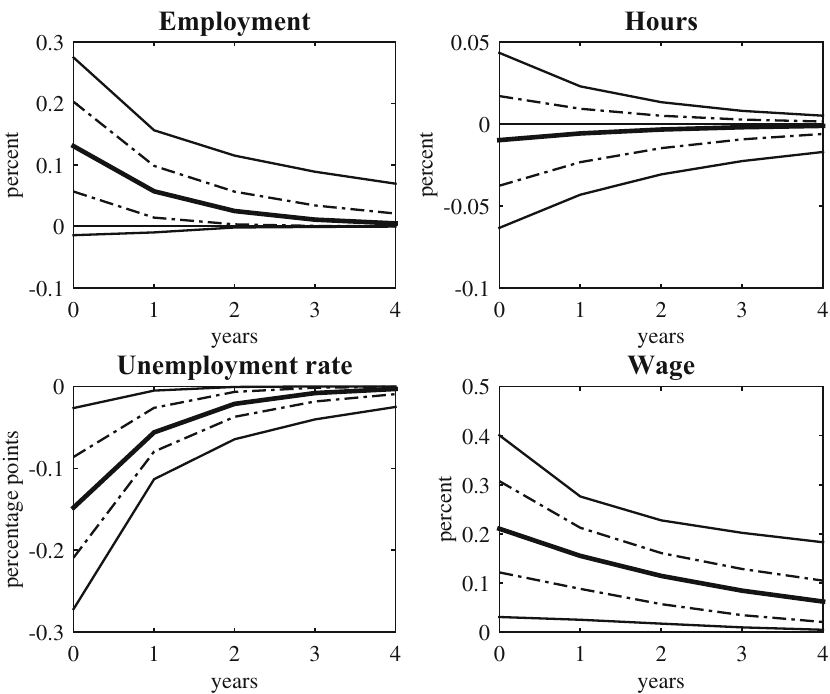
Fig.4 Dynamic response of labour market indicators to transfers shocks. Notes: response to an exogenous shock to old age pensions equivalent to 1% of GDP. Full lines are point estimates; thin and broken lines indicate 68 and 95% CIs,